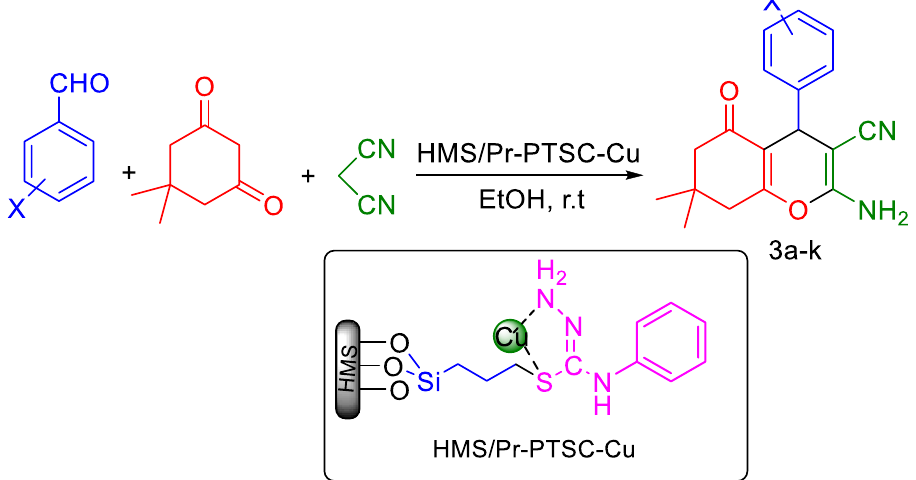
Figure 23. General procedure for the synthesis of tetrahydrobenzo[b]pyran.